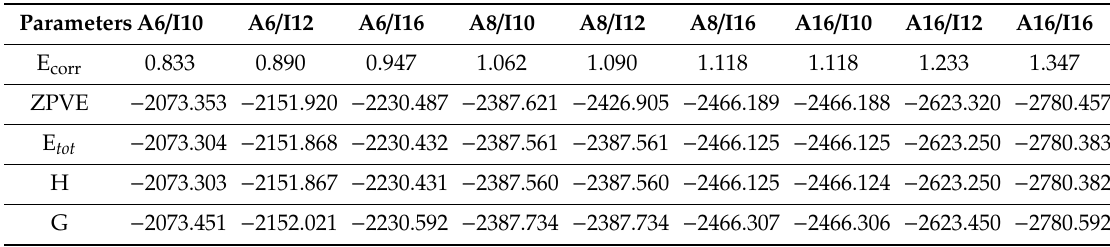
Table 3. Thermal parameters (Hartree / Particle) of both conformers of the H-bonded complexes An / Im